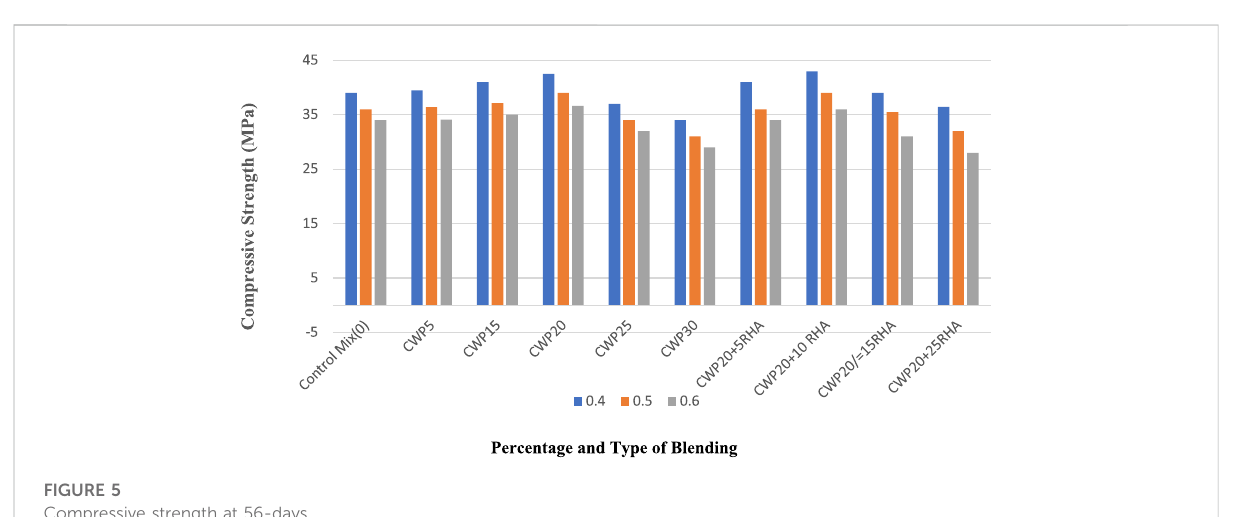
FIGURE 5 Compressive strength at